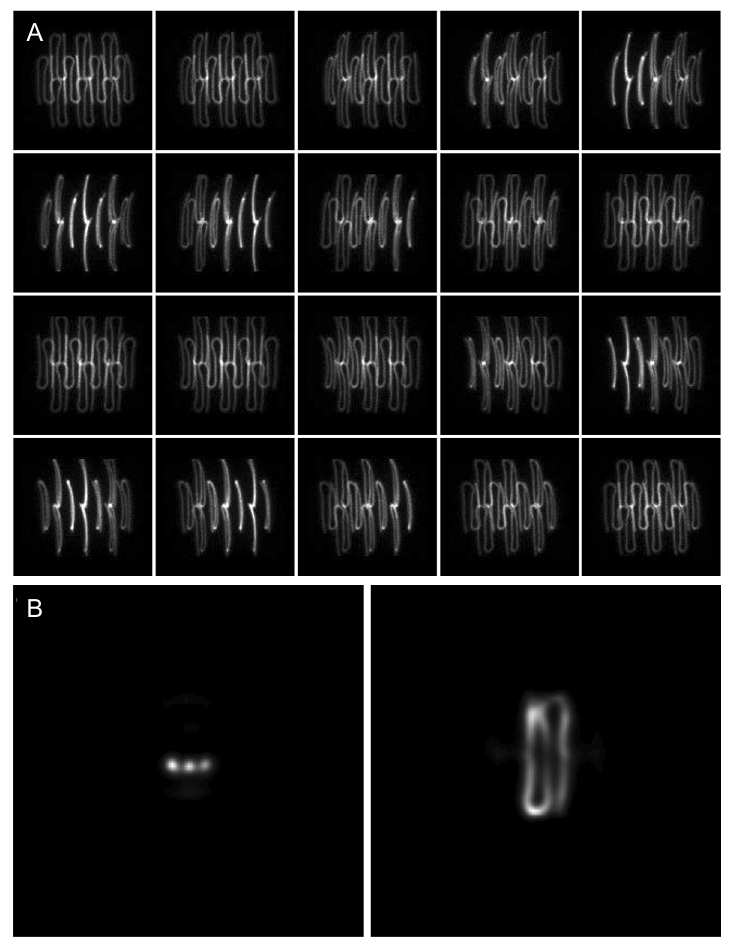
Figure 5. A , Twenty projections of a curved 1-mm diameter catheter filled with <0.1 mCi of 99m Tc, acquired with a multipinhole collimator consisting of 10 pin- holes 1 mm in diameter, as shown in Figure 1A. B , Transverse and horizontal planes through the center of the decoded object. Decoding was done with an iterative algorithm based on maximum likelihood expectation maximization, with 5